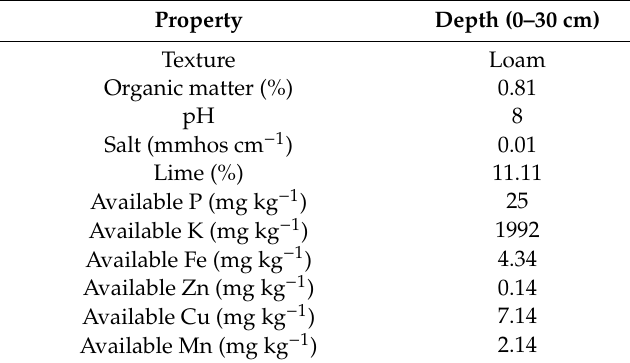
Table 1. Initial chemical and physical properties of the soil.